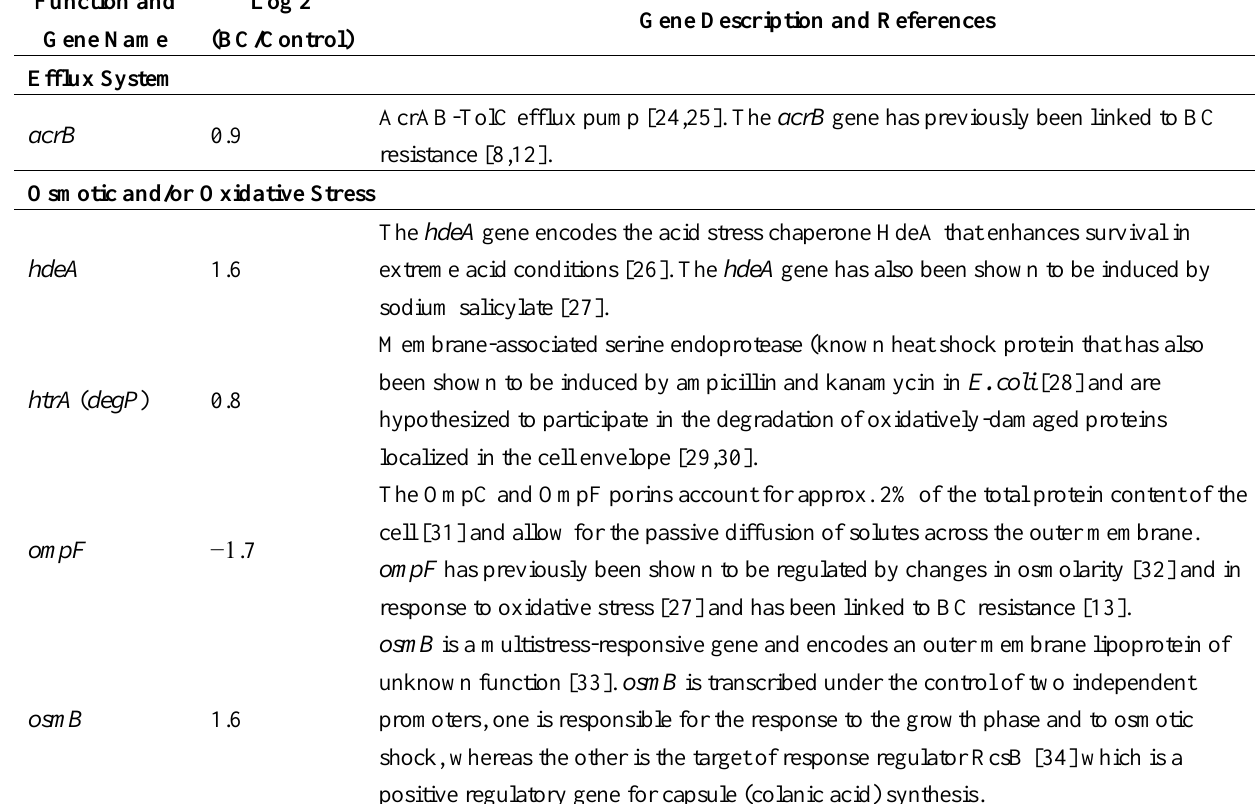
Table 1. Genes significantly different (FDR < 0.05) in BC (9 µg/mL) compared to the control (based on two new microarray experiments and data from a previous experiments [18]) and corresponding t -values, expression (log 2 compared to the control) and